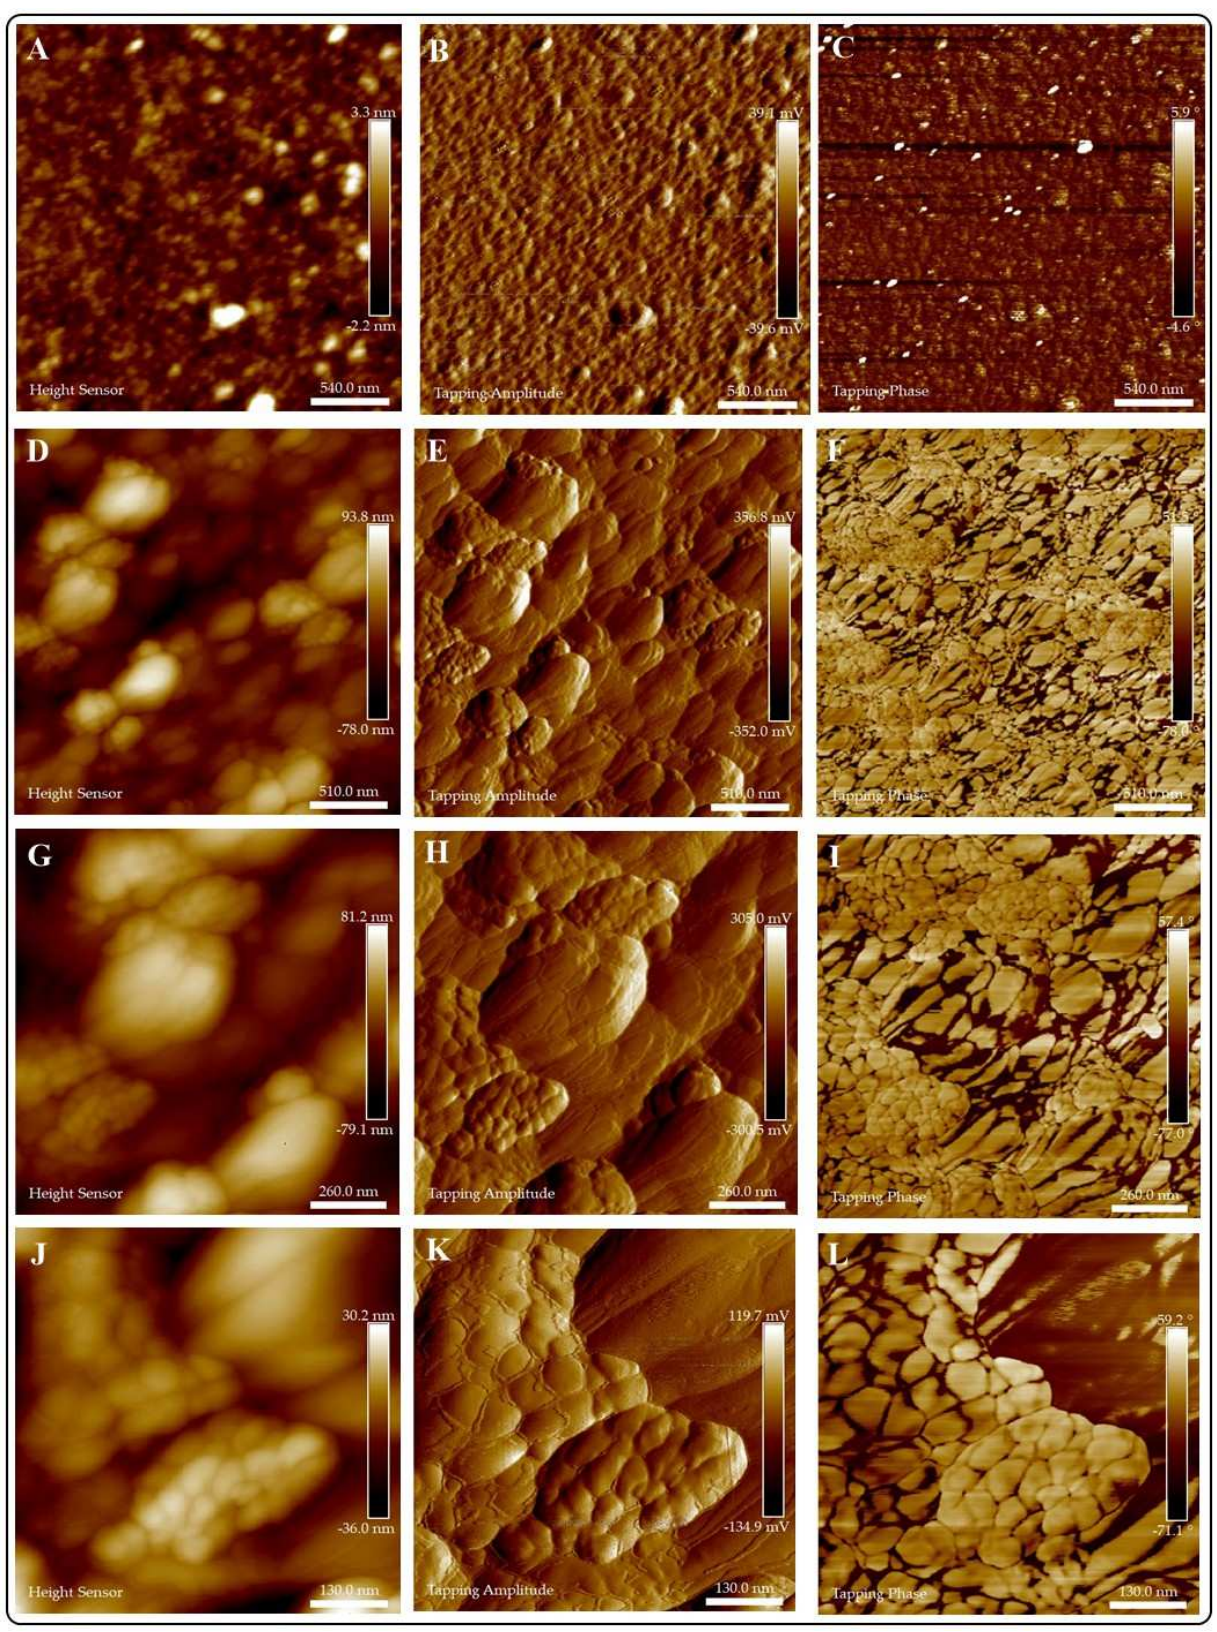
Figure 5. AFM analysis of Chitosan (Ch) and CuI@Ch films. ( A – C ) Chitosan thin films; Height, amplitude and phase analysis respectively. ( D – L ) CuI@Ch composite films; height, amplitude and phase analysis at different